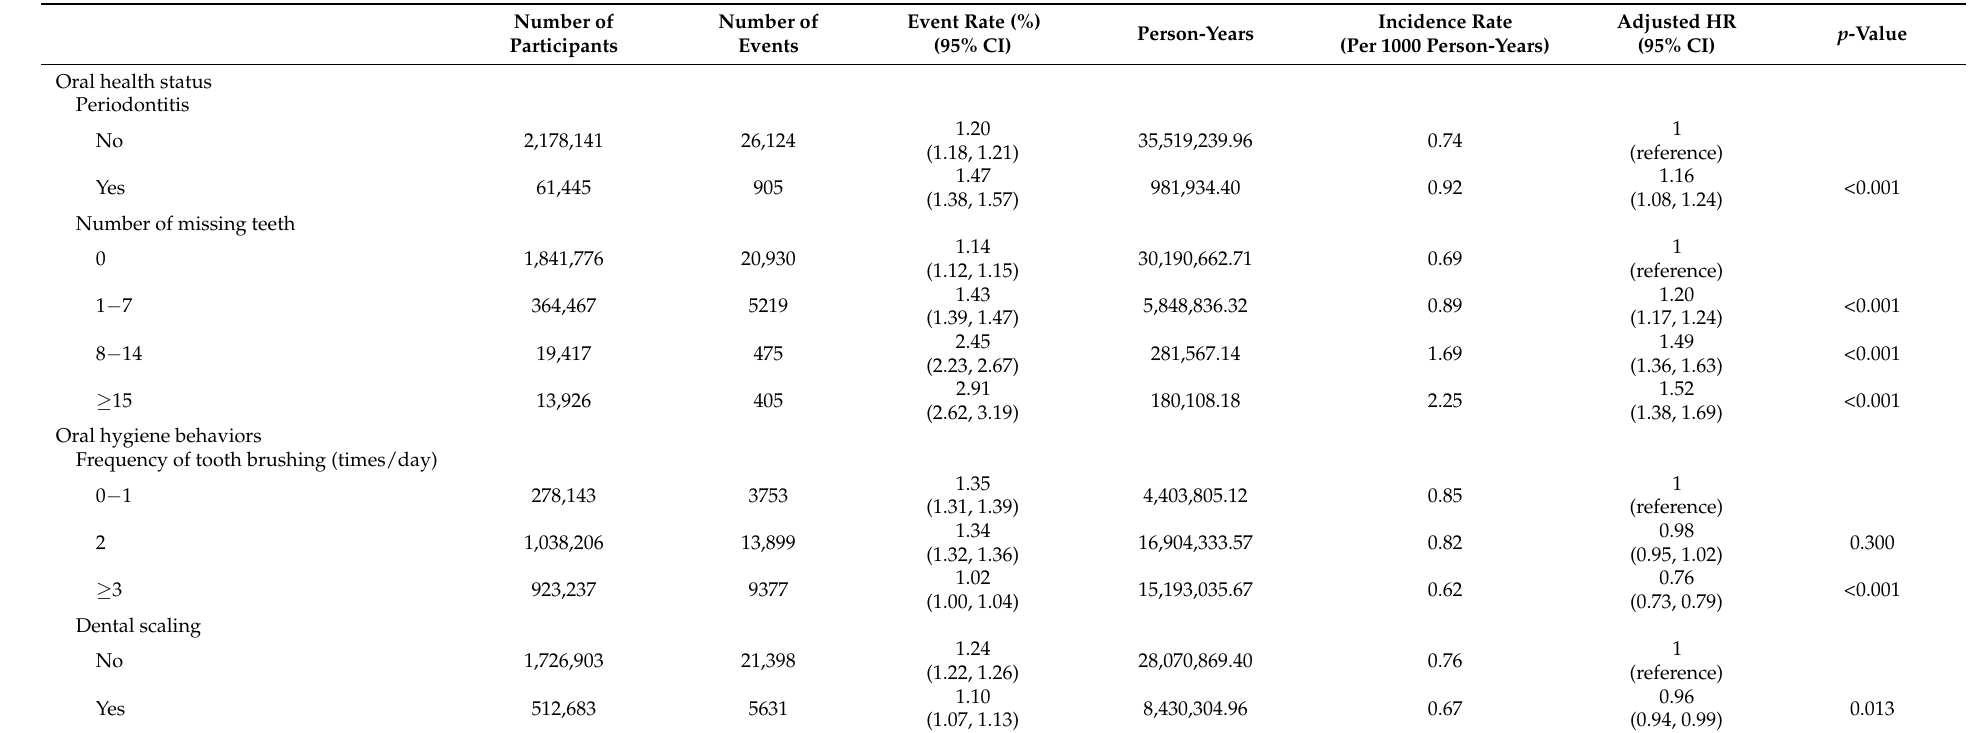
Table 2. Association of oral health status and oral hygiene behaviors with the occurrence of rheumatoid